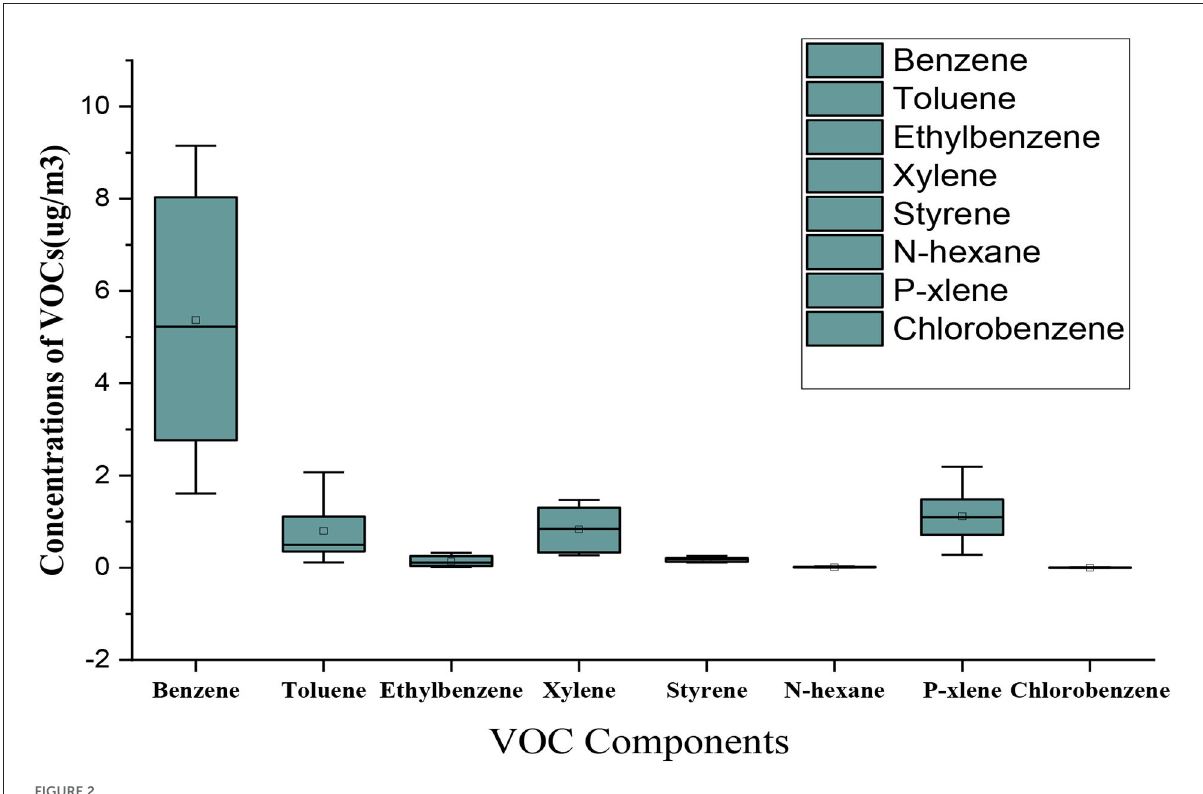
FIGURE2 The comparison of the measured concentrations of VOCs in different study areas.